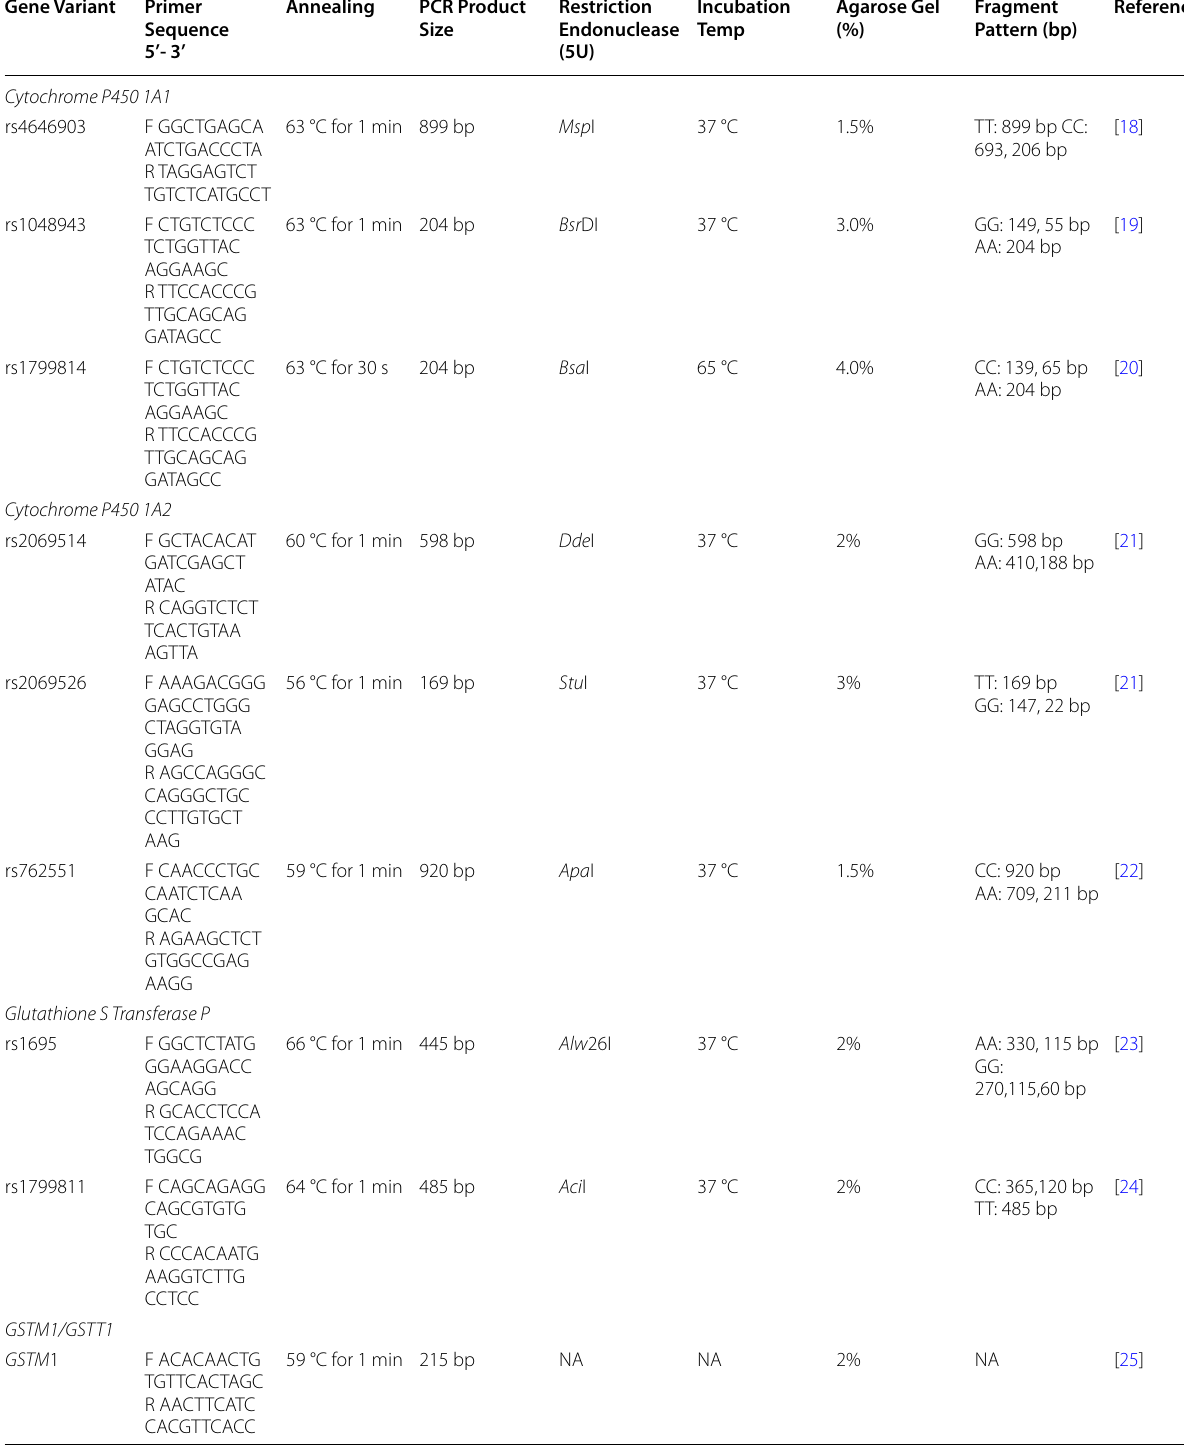
Table 1 Primers, restriction enzymes and PCR–RFLP conditions for the CYP1A1, CYP1A2 and GST gene variants studied Gene